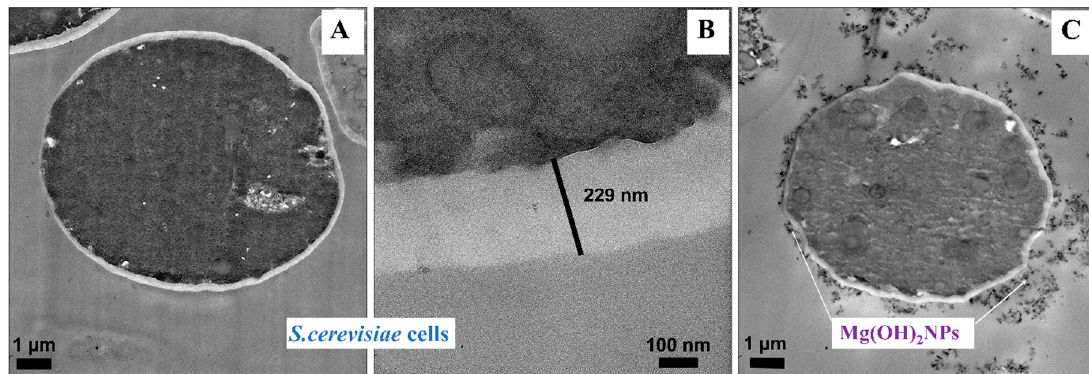
Figure 5. Transmission electron microscopy (TEM) images of S. cerevisiae after being incubated for one day with bare Mg(OH) 2 NPs: ( A ) A control sample without Mg(OH) 2 NPs. ( B ) A high-resolution TEM image of the S. cerevisiae wall without Mg(OH) 2 NPs. ( C ) S. cerevisiae cells incubated with 1000 µg mL − 1 Mg(OH) 2 NPs showing the attachment of Mg(OH) 2 NPs to the outer cell surface.